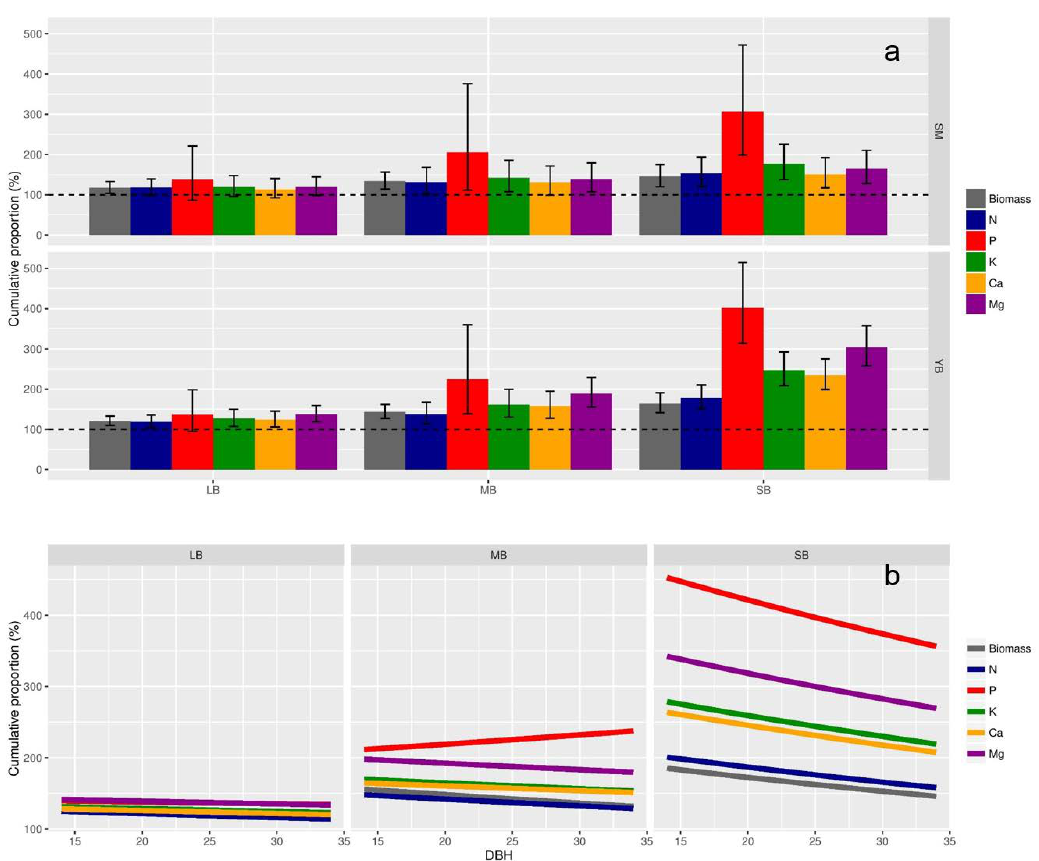
Figure 1. Cumulative proportion of nutrients and biomass within each of the branch compartments that were defined in the present study: large branches (LB; 10–5 cm), medium branches (MB; 5–2 cm), and small branches (SB; <2 cm). Values correspond to the parameters from the fixed part of the model with their associated standard errors. The upper panel illustrates the interaction between the branch parameter and tree species for an average-sized tree (DBH = 24 cm). The lower panel reports the interaction between branch parameter and tree DBH. SM = Sugar maple, YB = Yellow